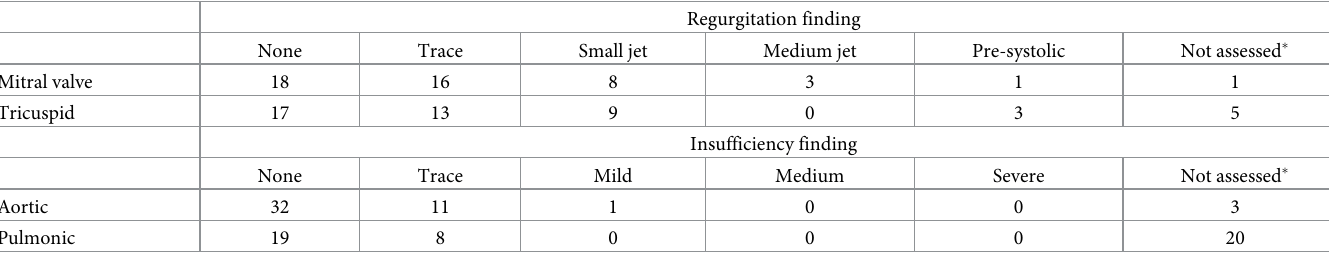
Table 3. Abnormal valvular regurgitation and insufficiency findings from echocardiographic analyses of BB